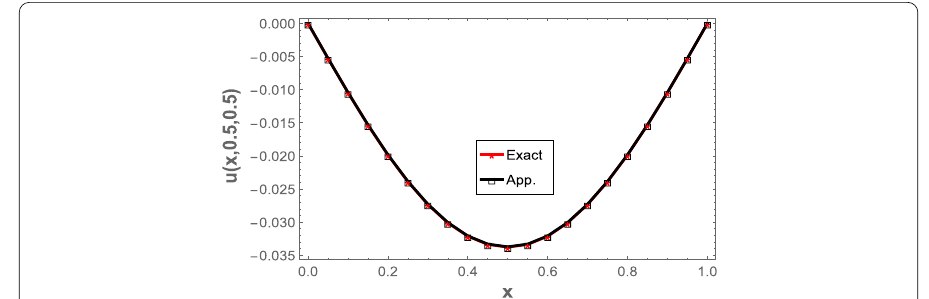
Figure 13 The numerical results compared to the exact results at y = z = 0.5